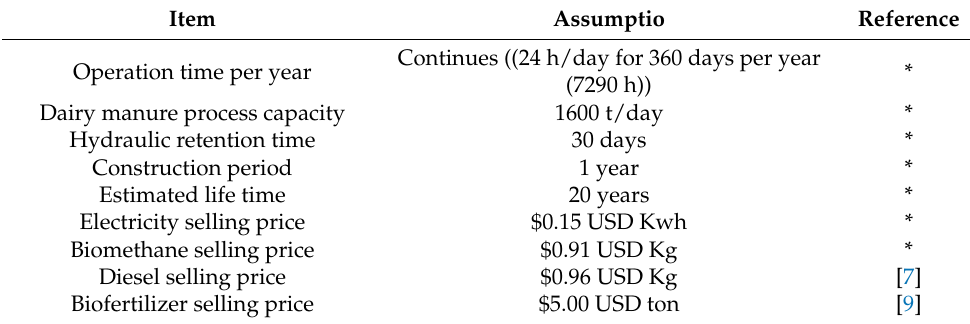
Table 1. Assumptions for building